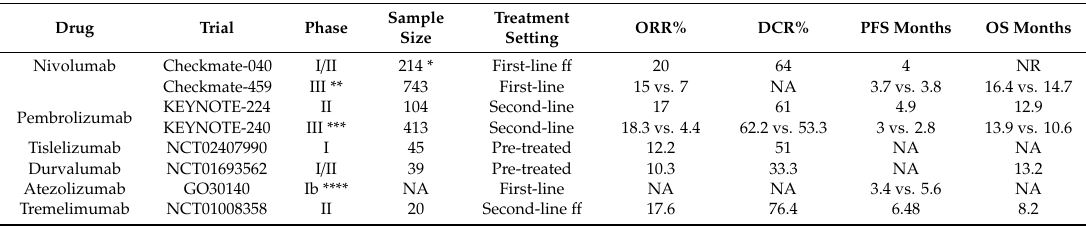
Table1. Summaryofclinicaltrialsconductedwithanti-PD-1, anti-PDL-1, andanti-CTLA-4monotherapy in HCC.